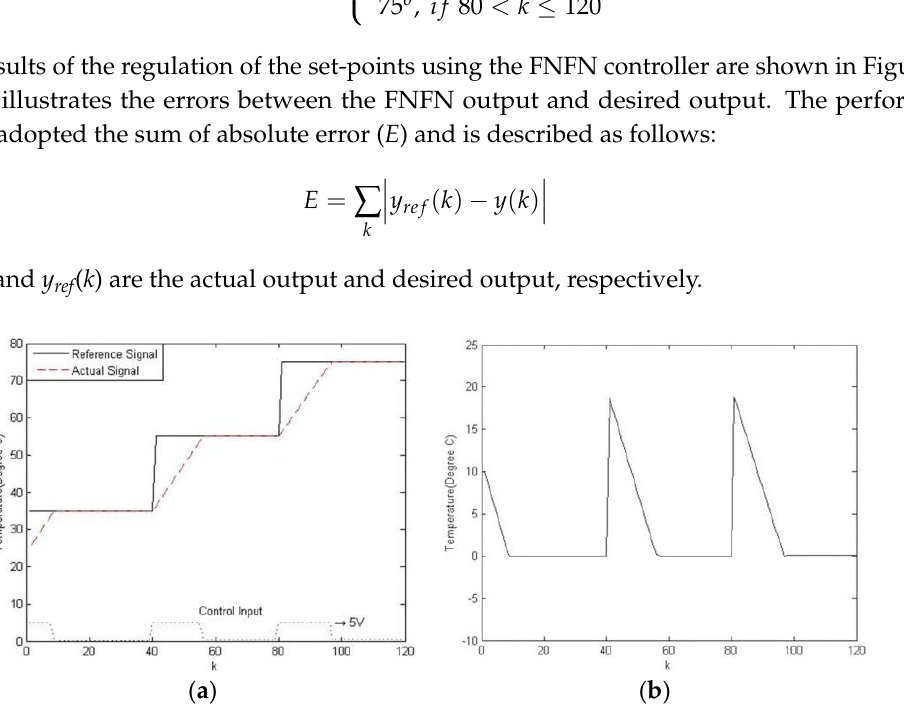
Figure 24. ( a ) The regulation outputs and ( b ) errors of FNFN controller in the water bath system.